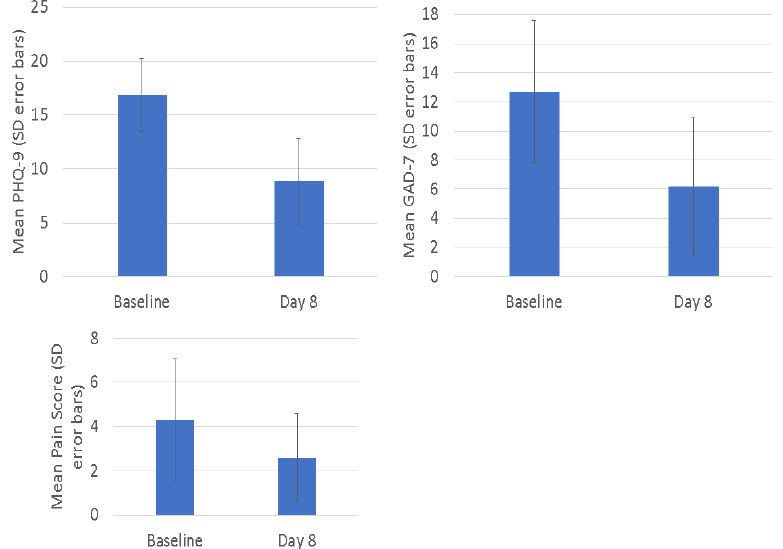
Figure 3. Secondary outcomes. Mean scores with standard deviation (error bars) shown.